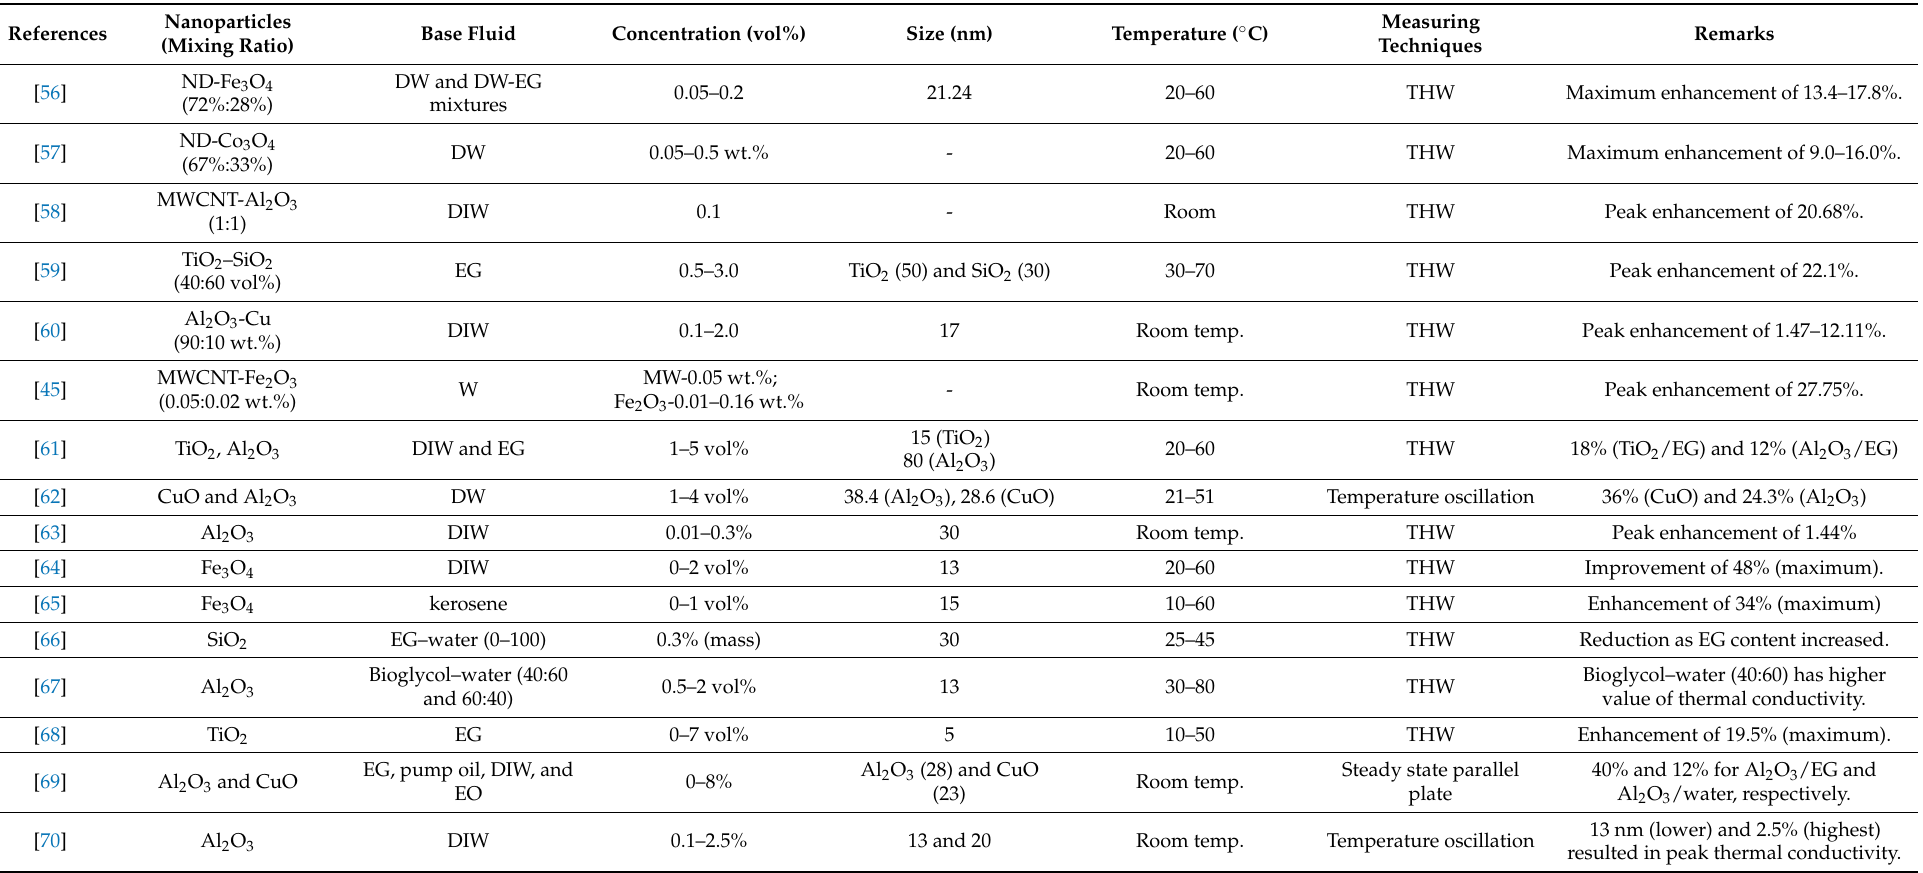
Table 1. Thermal conductivity and measuring techniques of different mono and hybrid nanofluids with dissimilar particle sizes at varying concentrations and